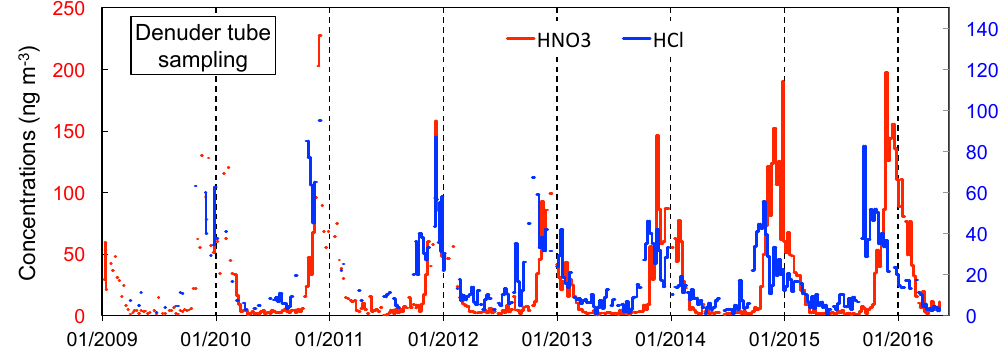
Figure 3. Year-round records of HCl and HNO 3 sampled on denuder tubes at Concordia from January 2009 to April 2016.